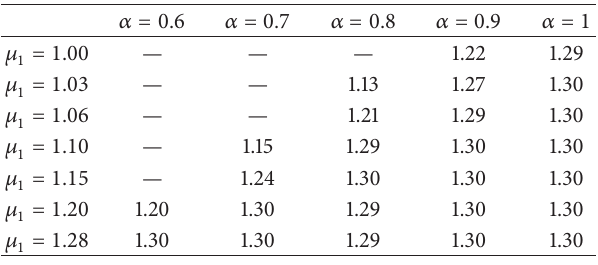
Table 2: The allowable maximum 𝜇 2 along with 𝜇 1 for different 𝛼 .